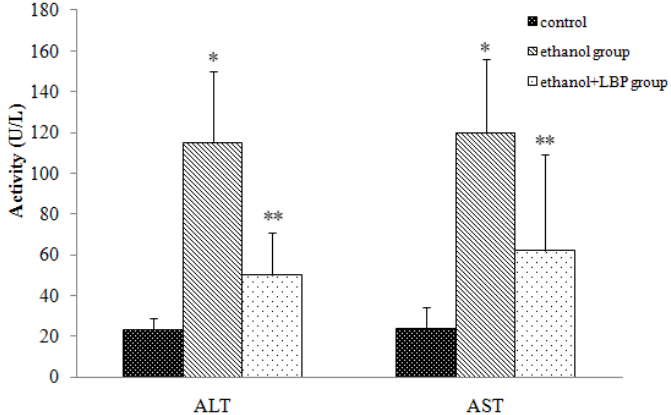
Figure 1. Effects of LBP on serum ALT and AST activities in rats. Values are expressed as mean ± SD for 12 rats in each group. * p < 0.01, ethanol group vs. control group. ** p < 0.01, ethanol + LBP group vs. ethanol